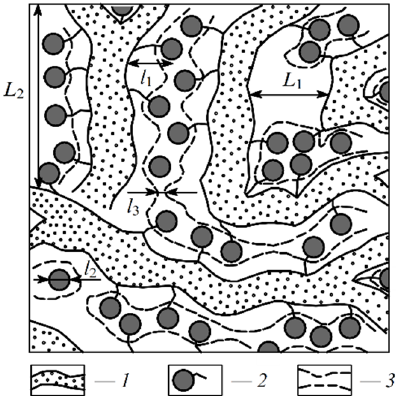
Figure 4. Structure of the amorphous part of the perfluorinated sulfonate cation-exchange membrane. (1) Polymer backbone; (2) hydrated counterions and functional groups at a low moisture content; (3) transport channels for ions and water molecules at a high moisture content; L 1 = 4 nm according to small angle X-ray scattering (SAXS) data; L 2 = 10 nm according to Mössbauer spectroscopy; l 1 = l.2–1 nm according to ENDOR and relaxation NMR data; l 3 = 1.5 nm according to standard porosimetry and ENDOR methods (adapted from